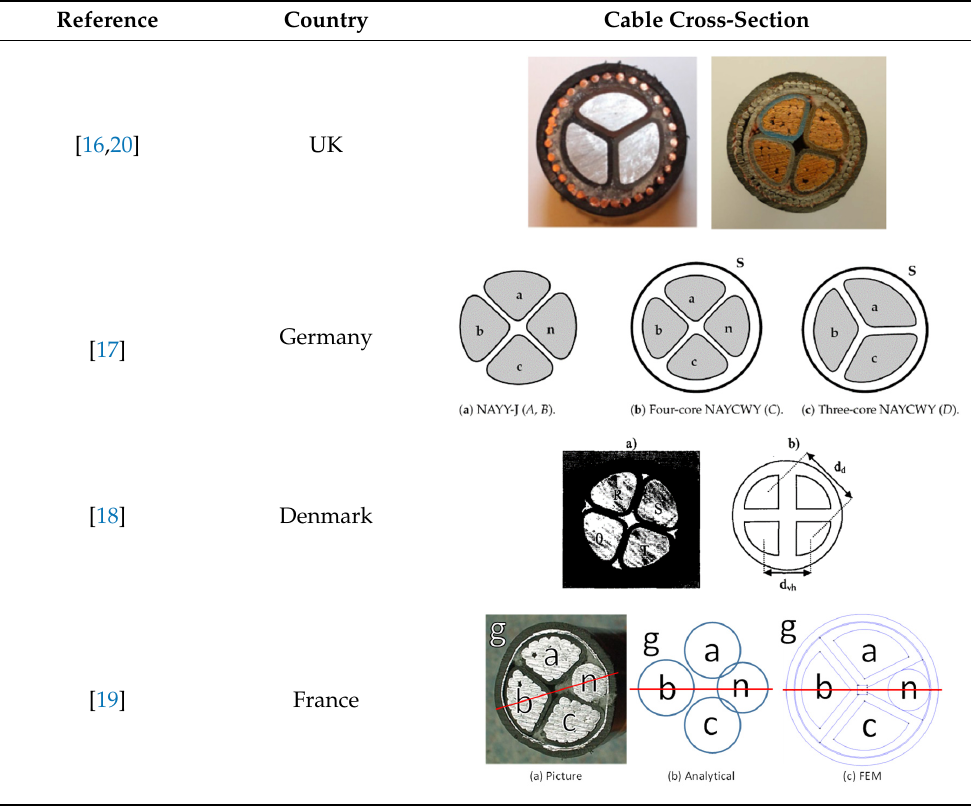
Table 1. Cross-section of European LV cables.